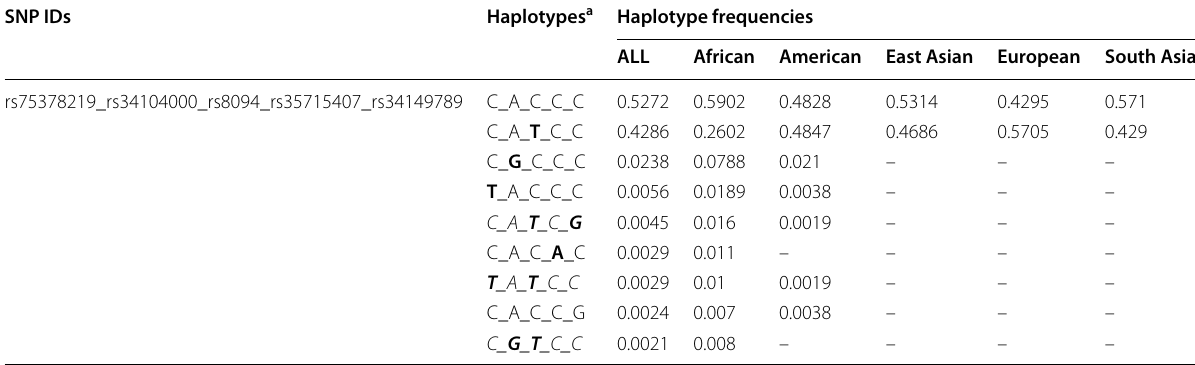
a Variant DNA bases are written in bold letters, and haplotypes containing more than one variant are written in italics